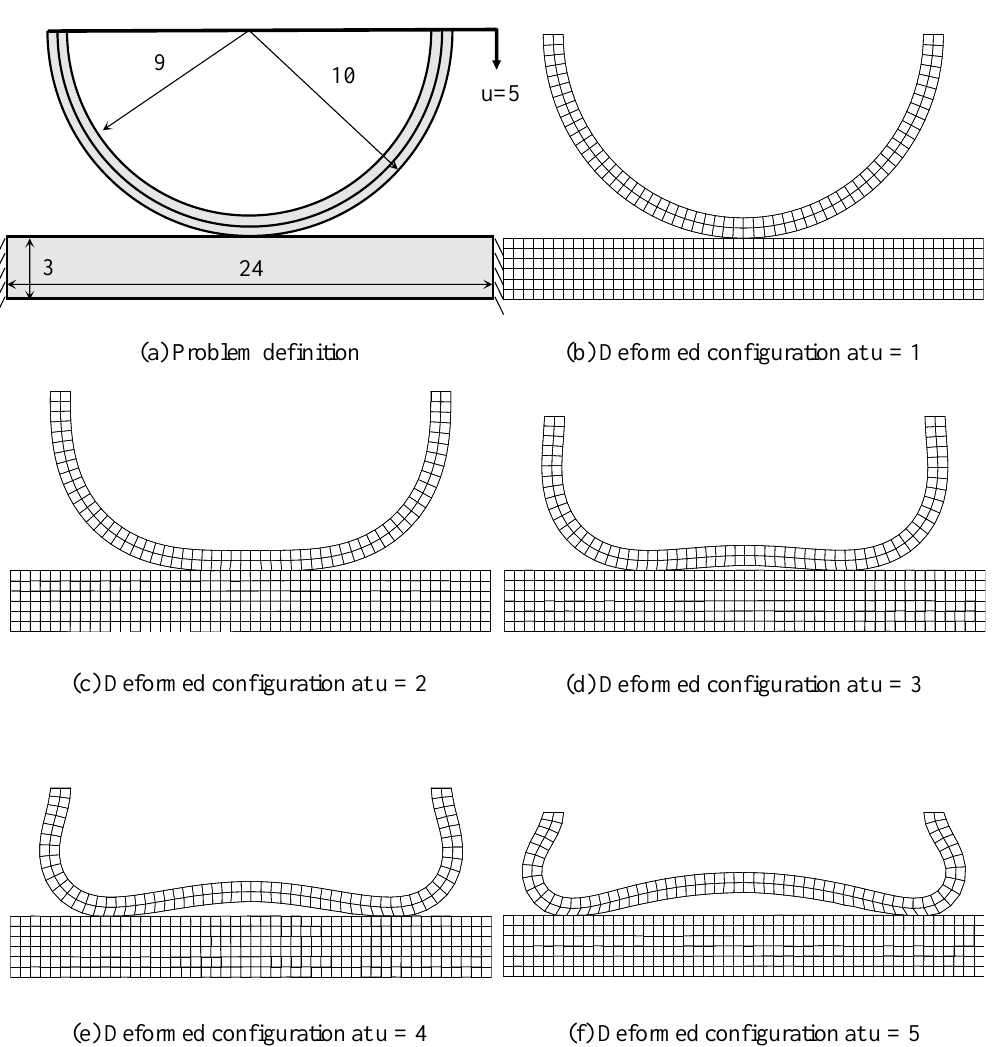
Figure 5. Problem definition and deformed configurations of a ring with rigid support.